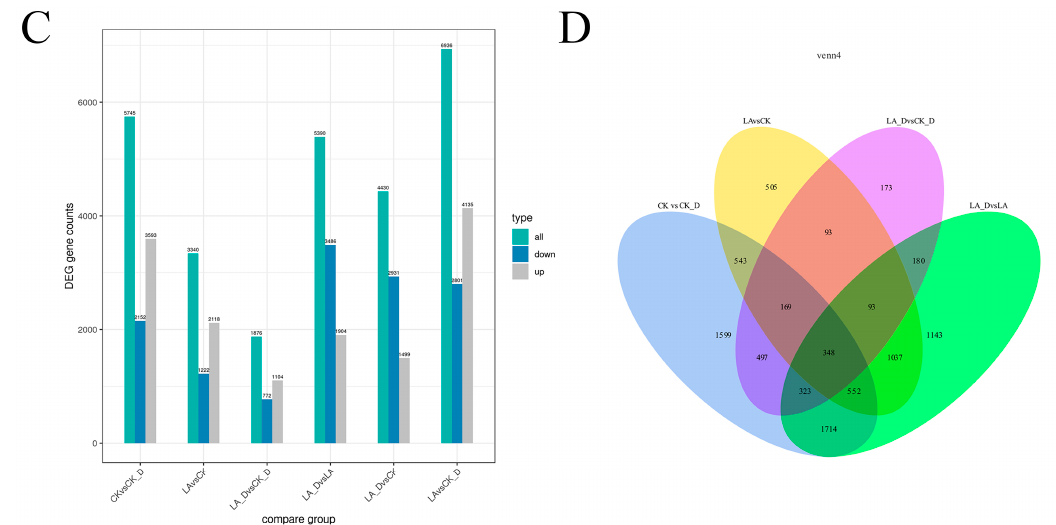
Figure 6. Correlation and differentially expressed genes among treatments at different sampling. ( A ) Heat map of the correlation coefficient between samples. ( B ) Principal component analysis (PCA) is also commonly used to assess inter-group differences and intra-group sample duplication. ( C ) Number of DEGs among the six comparison groups. ( D ) Venn diagram of differential gene expression analysis of DEGs.